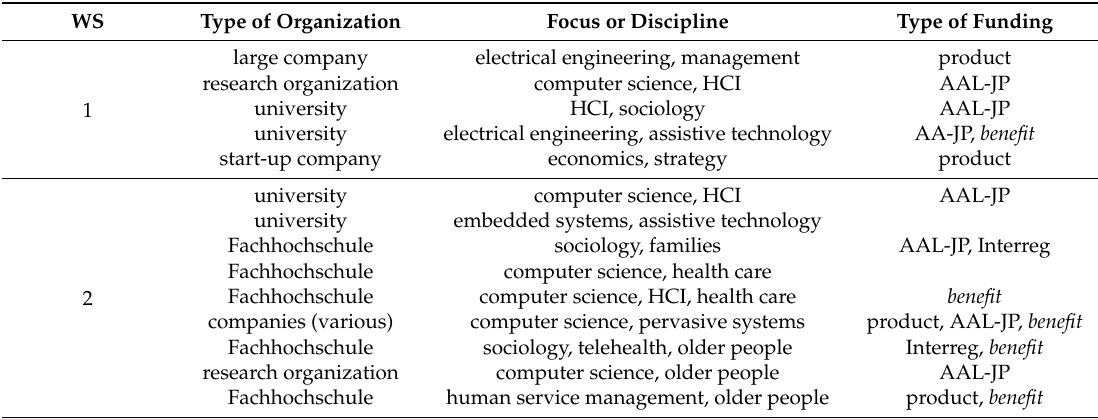
Table A1. Information about workshop participants. The column WS indicates in which workshop the person participated. Under Type of funding, benefit is a national funding scheme in Austria for AAL.